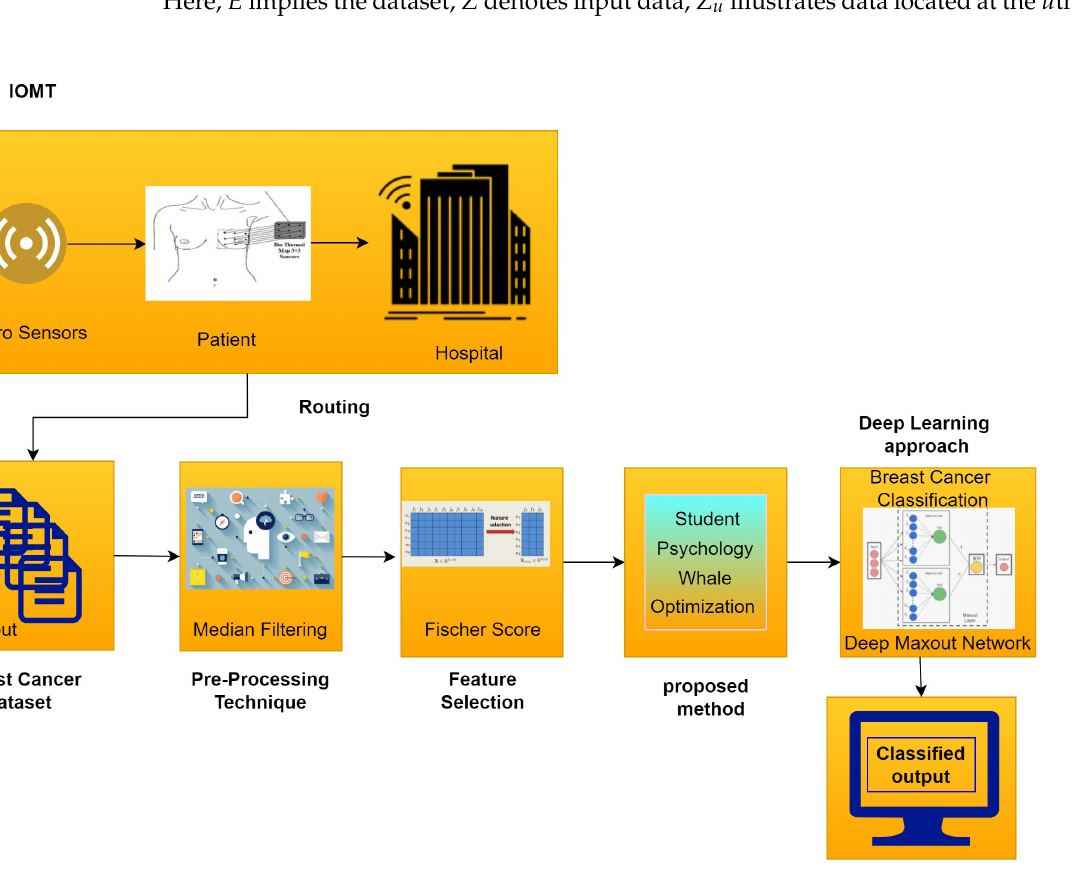
Figure 3. Portrays Schematic Representation of the Proposed